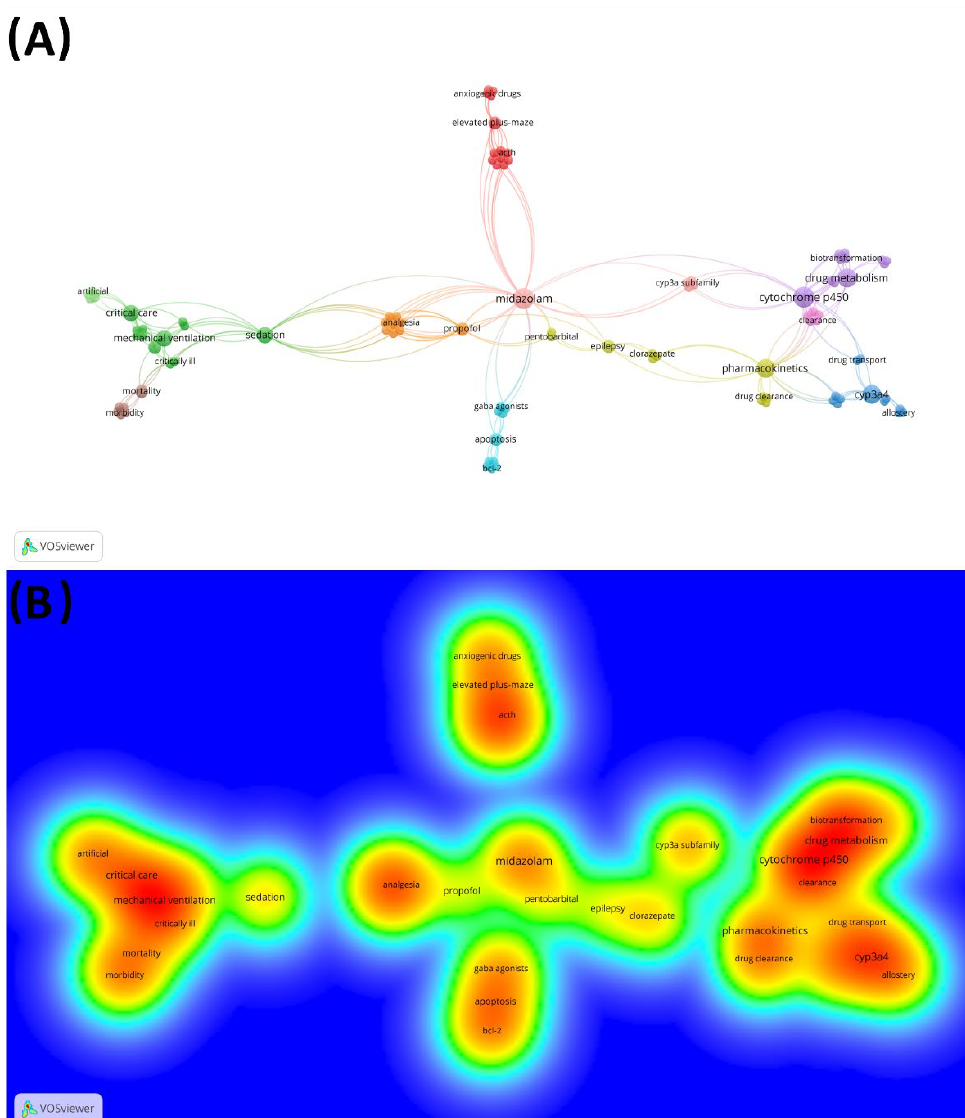
Figure 4. Network of co-occurrence and density-citation view of keywords used by the authors on the 100 most-cited studies about Midazolam. ( A ) Keywords network, in which clusters are represented by different colors and the lines indicate co-citation links between keywords; ( B ) Keywords-density visualization ranging from blue (lowest density) to red (highest density).